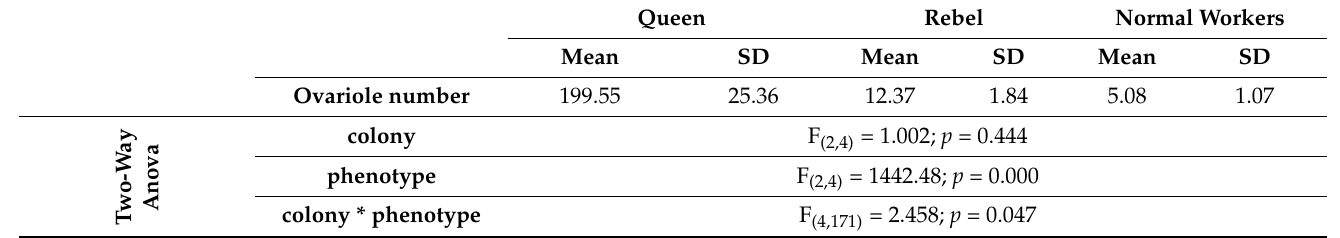
Table 4. Numbers of ovarioles in the A. mellifera queens, rebels, and normal (sterile non-rebel) workers. Queen